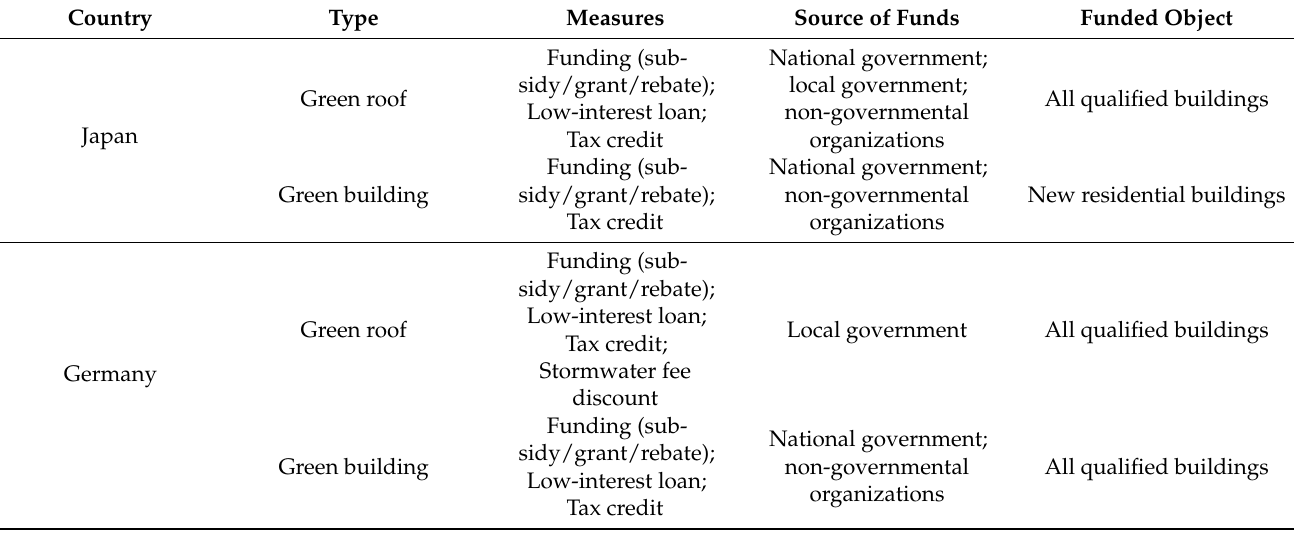
Table A2. Comparison of financial incentives encouraging the construction of green roofs and green